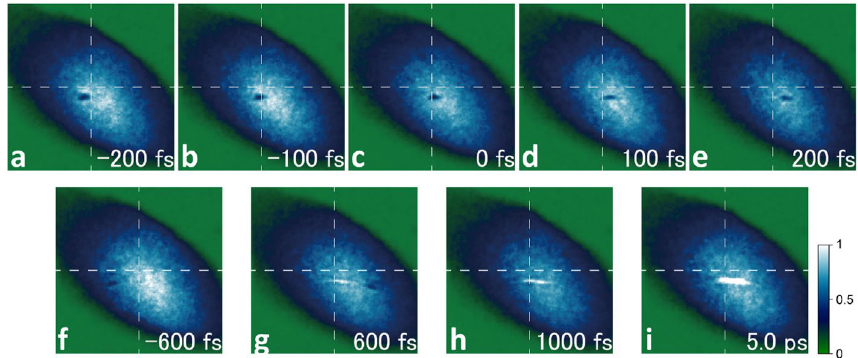
Figure 7. Electron-backlight images of an intense laser pulse propagating in a vacuum and the laser-induced plasma. ( a – i ) Snapshots of the shadow picture of the intense laser pulse with the electron pulses at 100-fs time steps ( a – e ) and − 600 fs, 600 fs, 1 ps, and 5 ps after passing of the laser pulse ( f – i ) obtained using the electron pulses. The experimental setup used to obtain these images was the same as that used to measure the timing jitter. Each snapshot is an average of 10 shots. The propagation of the laser pulse was measured in a vacuum chamber with a pressure of 5 × 10 −2 Pa. The laser pulse interacted with the small amount of residual gases